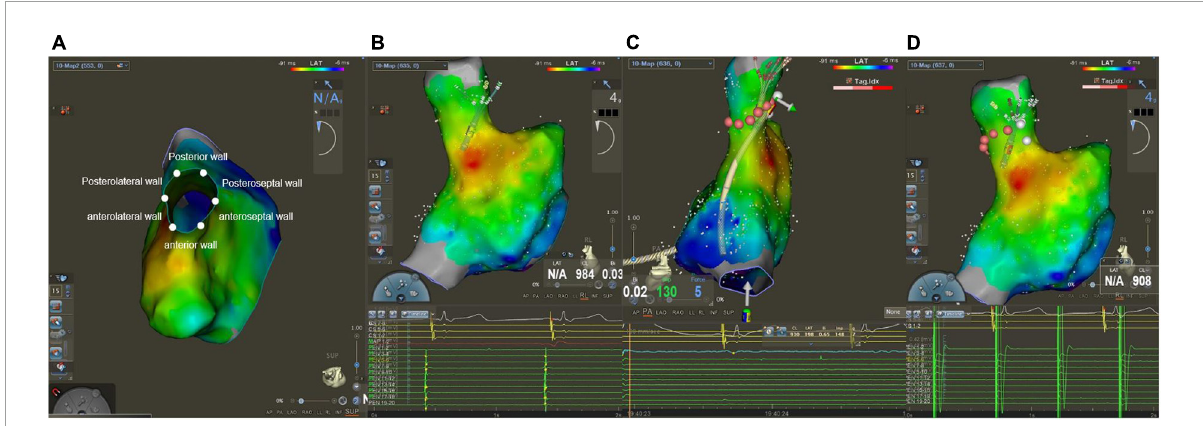
FIGURE1 Mapping and ablation of superior vena cava (SVC). (A) Anterior, anterolateral, posterolateral, posterior, posteroseptal, and anteroseptal segments in a cranial view. (B) Potentials from sinus rhythm in SVC before ablation. (C) Absence potential in SVC after ablation. (D) Dissociation of SVC potential during pacing.